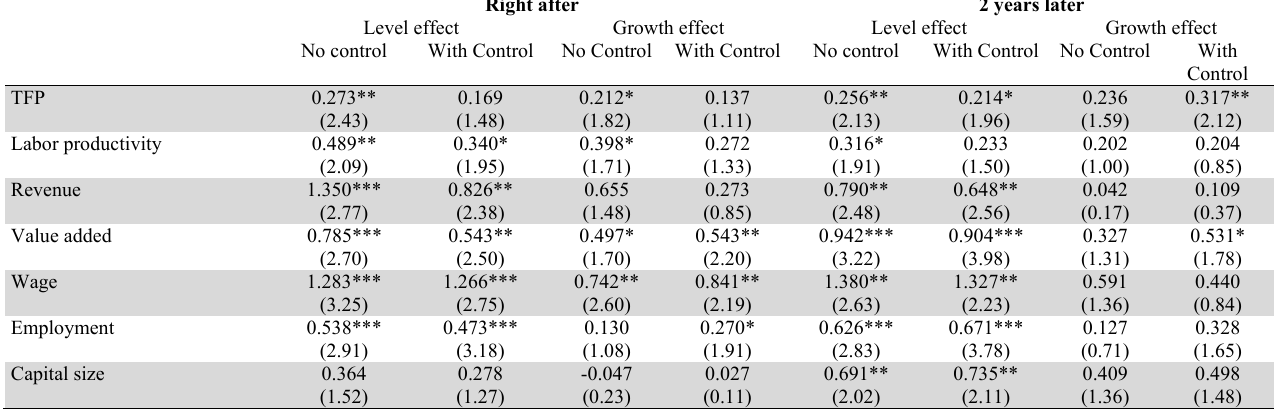
Year- to- year learning–by-exporting effects